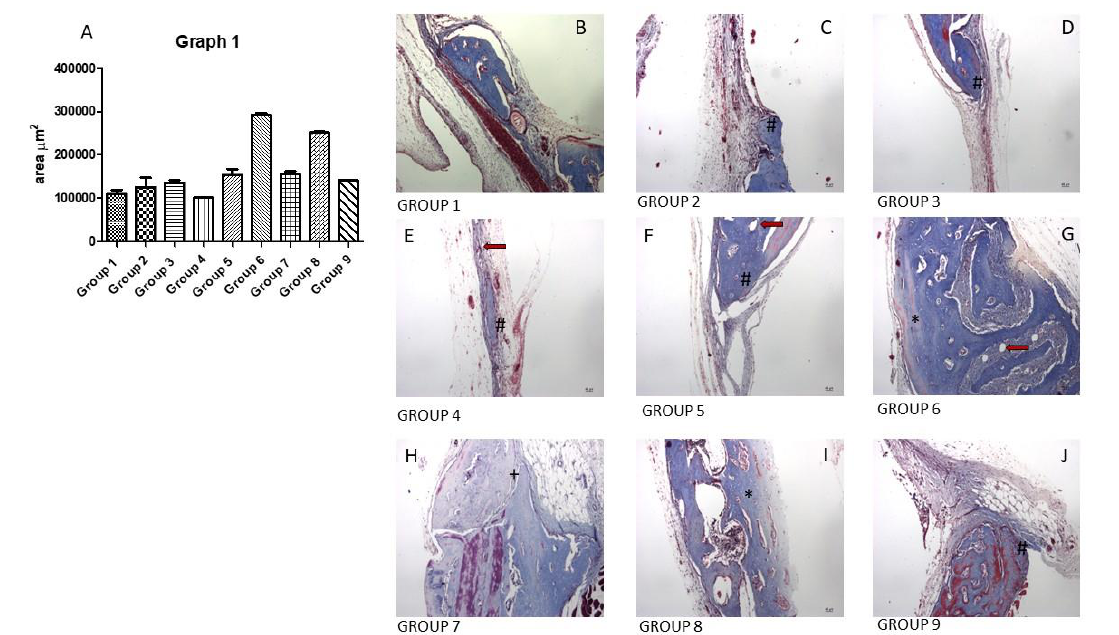
Figure 1. Quantitative and qualitative aspects of the bone defect region in the calvaria of the animals in all experimental groups. ( A ): Graph 1 shows the area of neoformed bone tissue in the bone defect region of the control group and the experimental groups. The graph reveals that there was a significant difference in groups 6 and 8 compared to all other groups. ( B – J ): Masson’s trichrome staining was performed to evidence the formation of bone tissue in the repair area. Photomicrographs were taken to show the newly formed bone tissue in the defect area of each group. The presence of osteoblastic cells and newly formed bone tissue can be observed, indicating bone repair of the recipient sites. Masson’s trichrome staining. Scale bar: 46 um. *: greater amounts of neoformed bone tissue, indicating the best results of the therapy used. #: smaller amounts of newly formed bone tissue in the wound region. +: large amounts of newly formed bone tissue, but without significant difference. Red arrow: bone gaps.